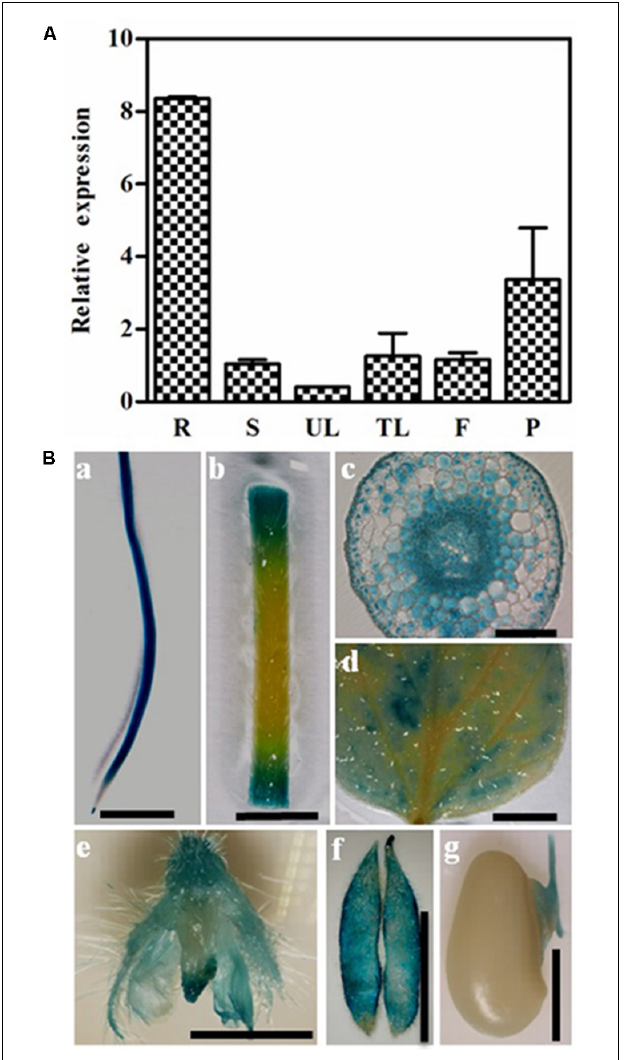
FIGURE 3 | Expression patterns of GmPIP2;9 . (A) Relative expression levels of GmPIP2;9 in root (R), stem (S), unifoliate leaf (UL), trifoliolate leaf (TL), flower (F), and pod (P). All data are means of three biological replicates with error bars indicating SD . (B) β -glucuronidase (GUS) staining of root (a) , stem (b) , cross section of root (c) , leaf (d) , flower (e) , pod (f) , and developing seeds (g) . Bar = 1 cm in a , b , d , e , and f . Bar = 1 mm in c and g